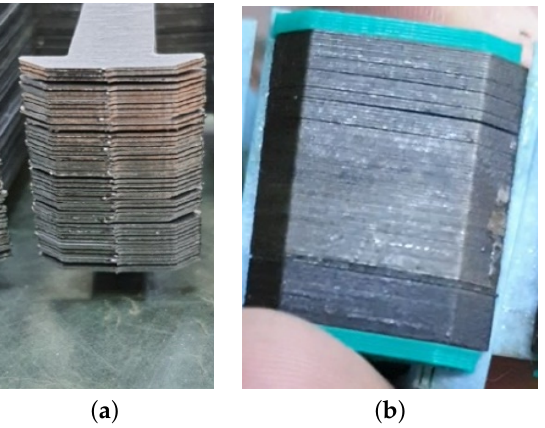
Figure 18. Comparison of the laser-cut stator and the wire-erosion-cut stator in terms of production tolerance. ( a ) Laser cutting. ( b ) Wire erosion